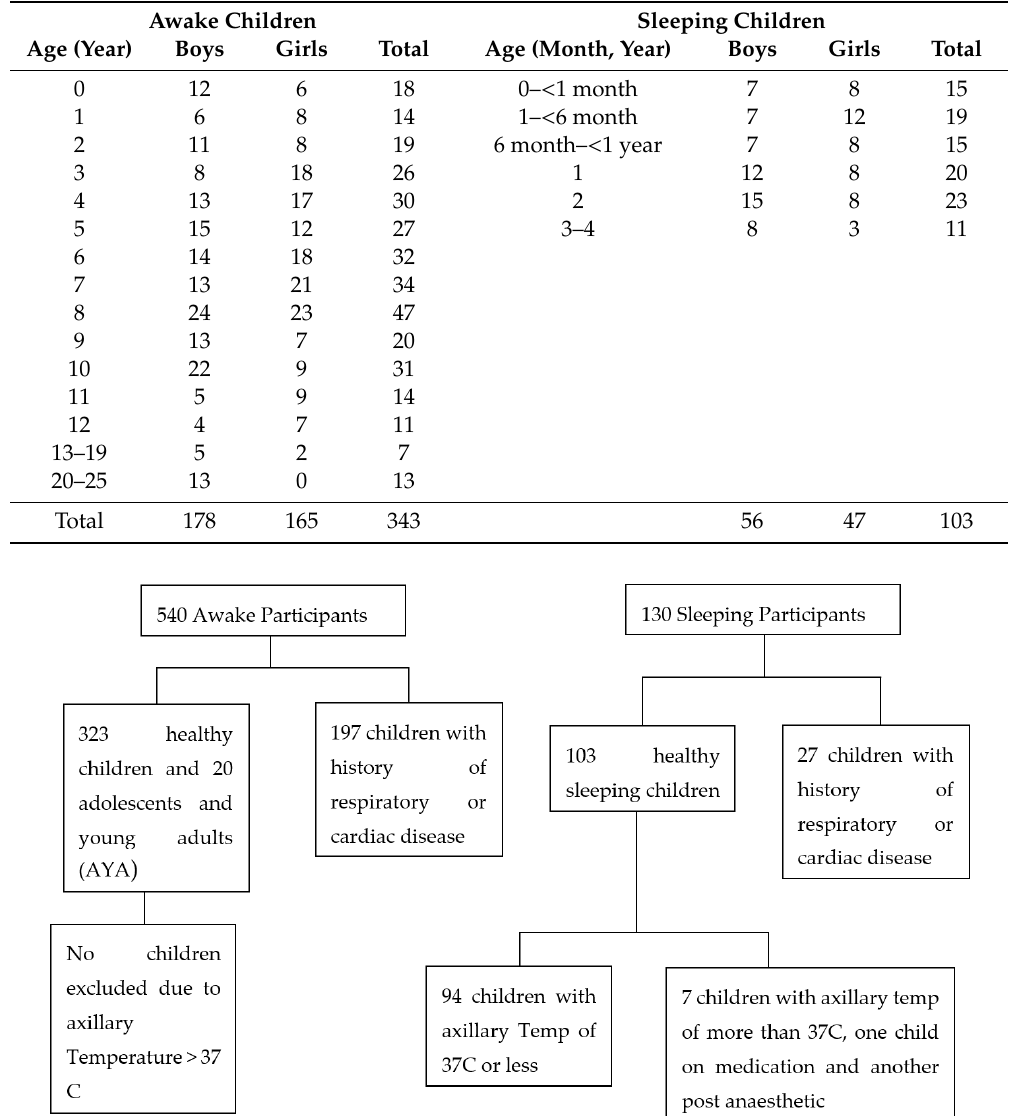
Figure 2. Flow chart showing children who were excluded from the stud and those included in the final evaluation. final